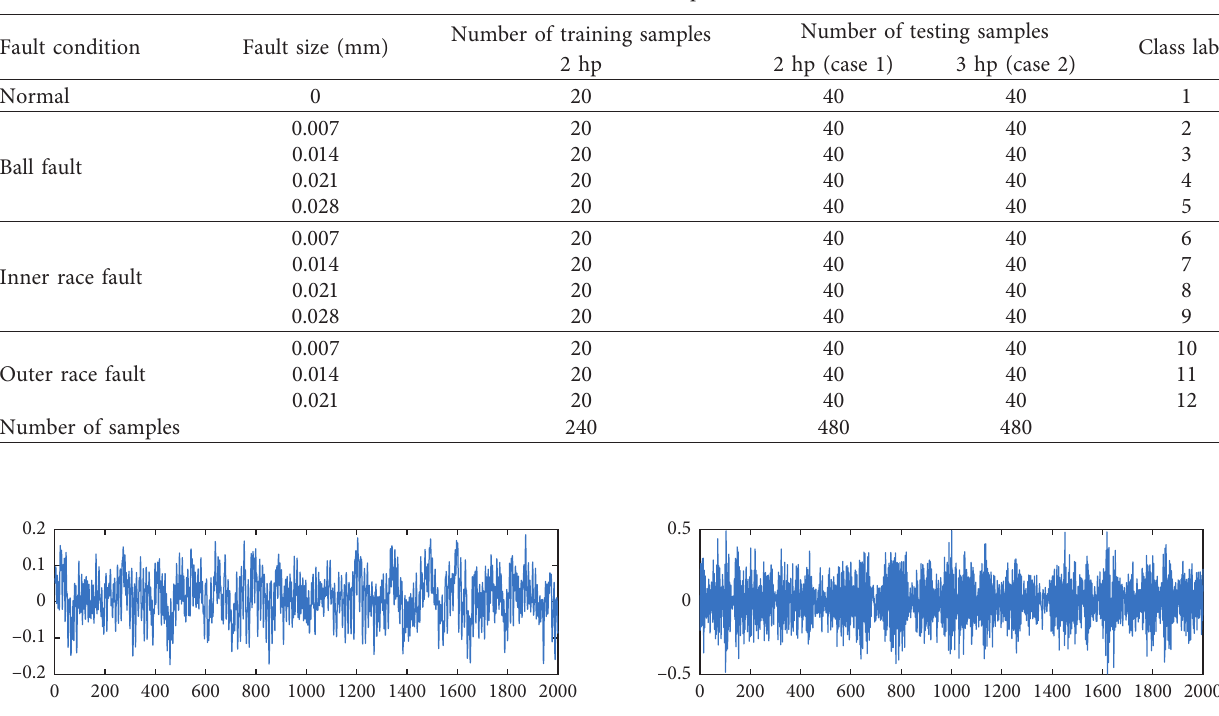
Figure 4: Bearings used in the SQI-MFS test platform. Table 2: The introduction of experimental data.